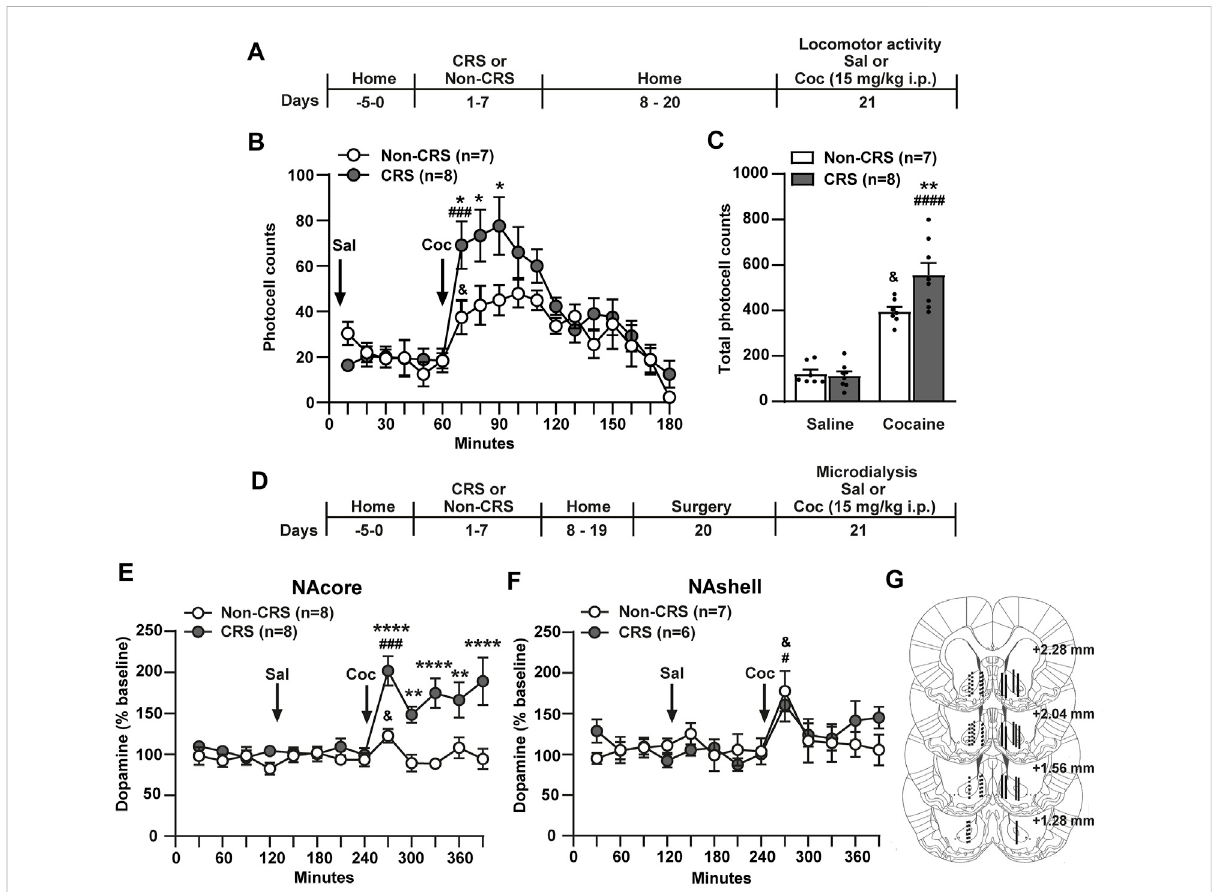
FIGURE 1 Chronic stress exposure induced behavioral and neurochemical sensitization to cocaine. (A) Schematic timeline of the experimental protocol. (B) Time course of horizontal photocell counts after saline and cocaine (15 mg/kg) i. p. injections. Time-frame from 10 to 60 min corresponds to saline administration at 0 min and time-frame from 70 to 180 min to cocaine administration. Two-way ANOVA with repeated measures over time revealedsigni fi cantinteraction(Non-CRSvs.CRSxtime; F (17,221) =1.88, p < 0.05),signi fi canteffectofstress(Non-CRS vs.CRS;F (1,13) =6.05, p < 0.05) and time (F (17,221) = 12.38, p < 0.0001). Bonferroni post-hoc test comparing Non-CRS with CRS after a cocaine challenge revealed signi fi cant differences at 70, 80 and 90 min (* p < 0.05). No differences were found comparing Non-CRS with CRS after a saline injection (n.s.). The